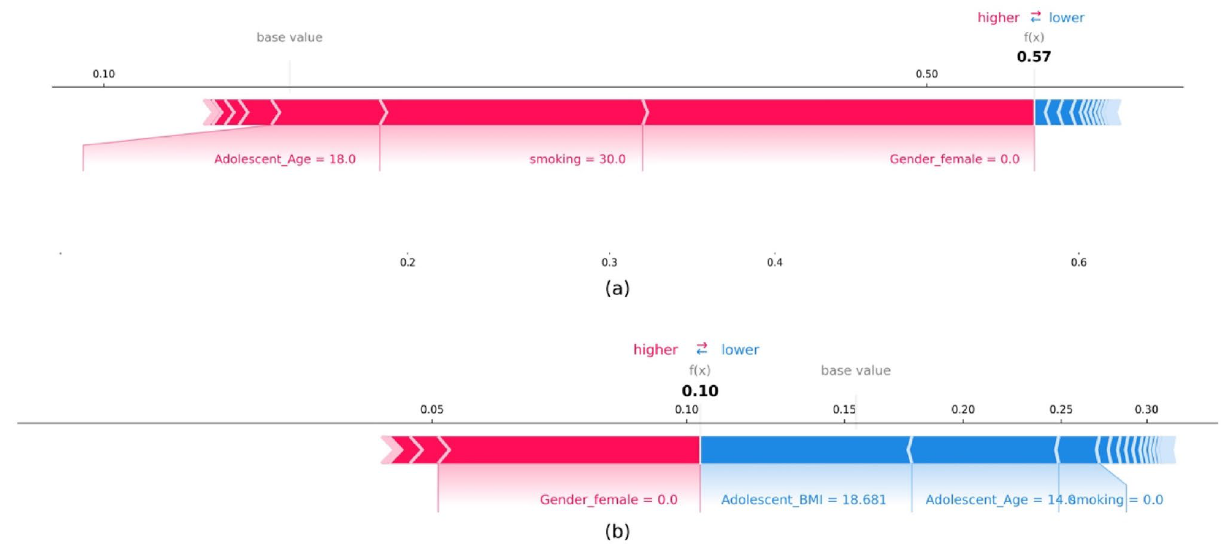
Figure 8. Local interpretation—force plots for two individuals from the testing set of the XGBoost model: ( a ) high risk individual, ( b ) low risk